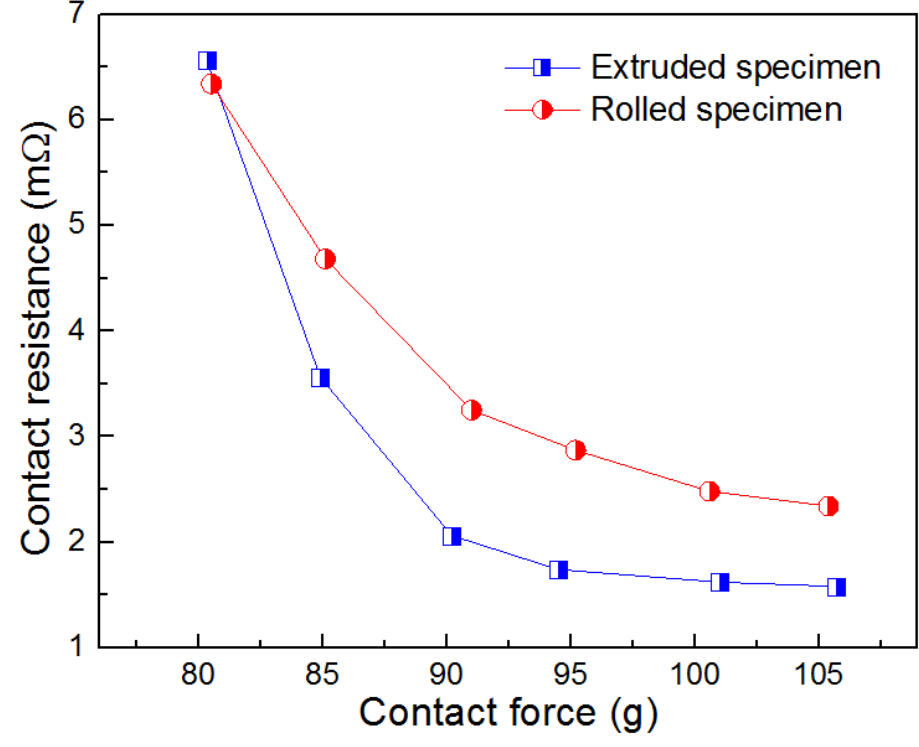
Figure 6. Changes of static contact resistance of CdMoO